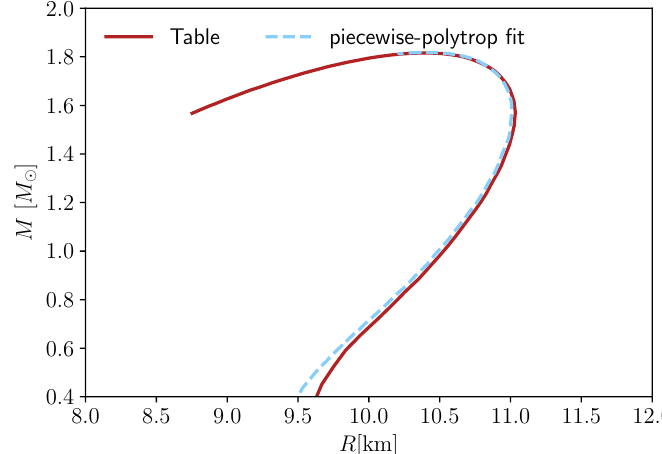
Figure 3. Mass-radius curves of the tabulated and piecewise-polytrope EoSs with a 4 = 0.70, a 2 = 5000 MeV 2 and B 1/4 = 150 MeV.